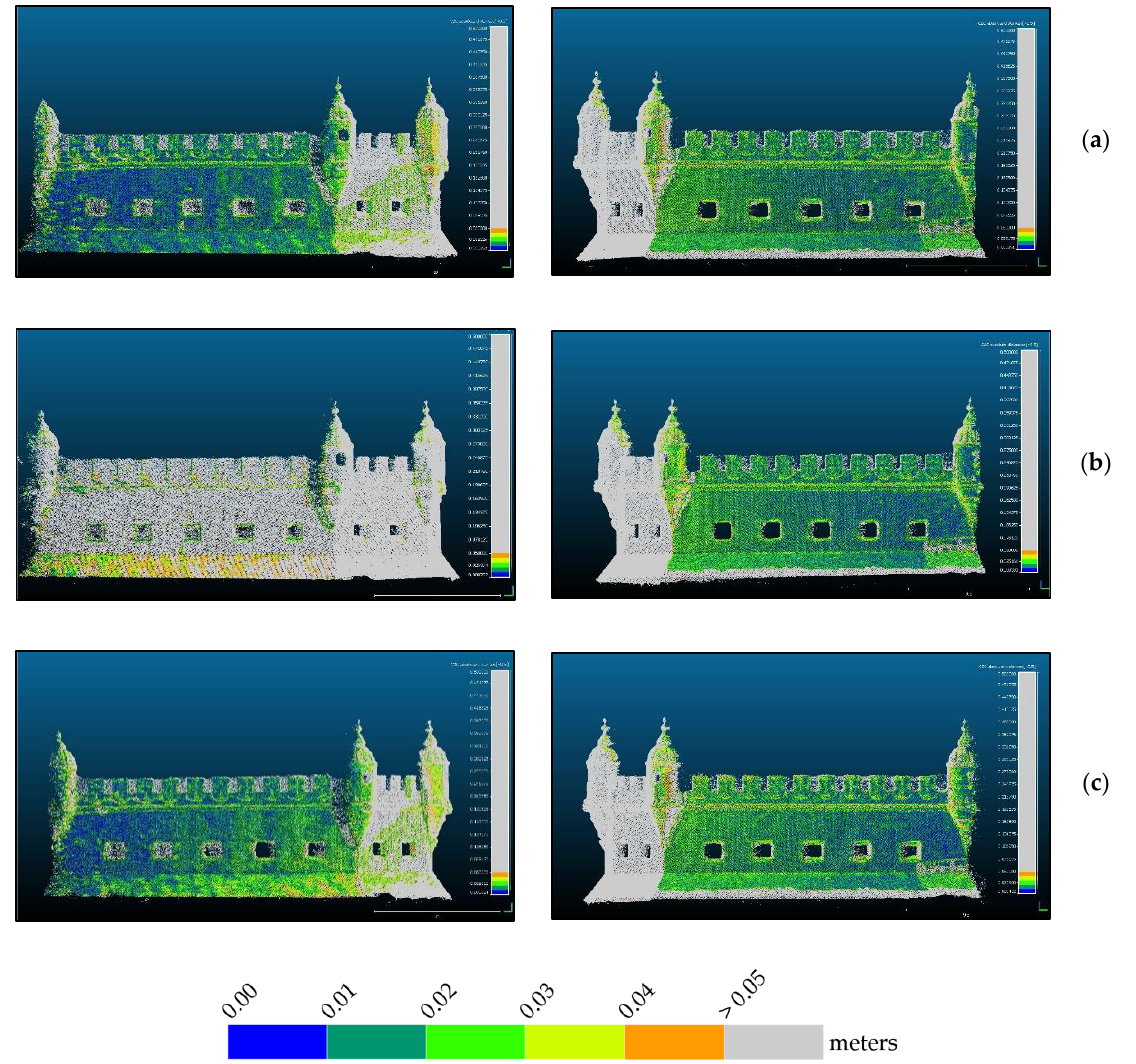
Figure 18. Distribution of points where residuals are smaller than 5 cm: (left) West bulwark façade; (right) East bulwark façade. ( a ) ICP; ( b ) Total station points; ( c ) TLS points.